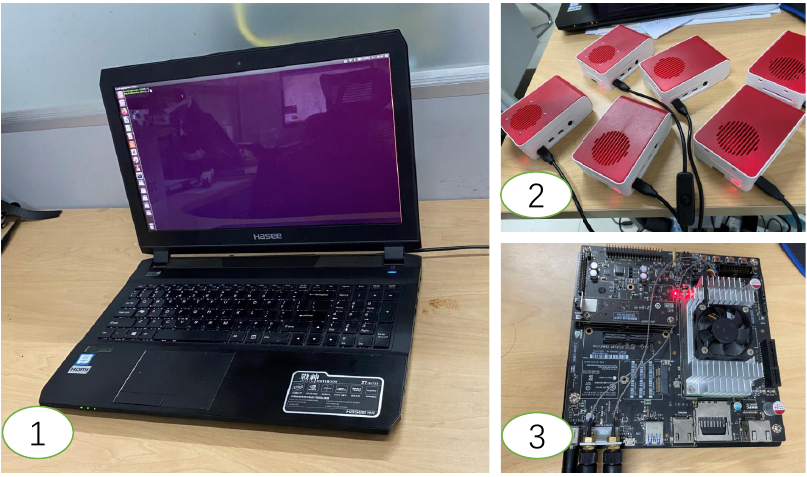
Figure 6. The three categories of hardware. Subfigures ( 1 – 3 ) show the Raspberry 4b, Jetson TX2, and the laptop, respectively.